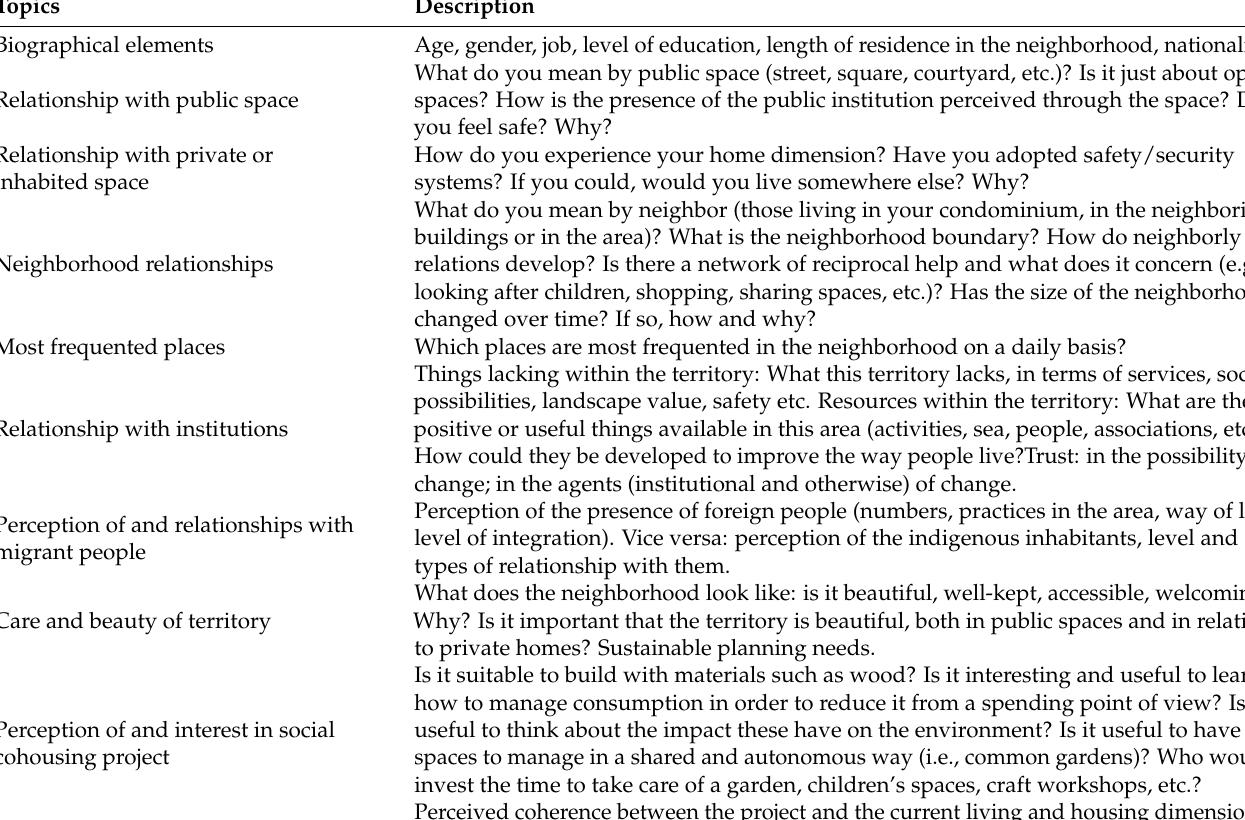
Table 1. List of TSR ® topics.